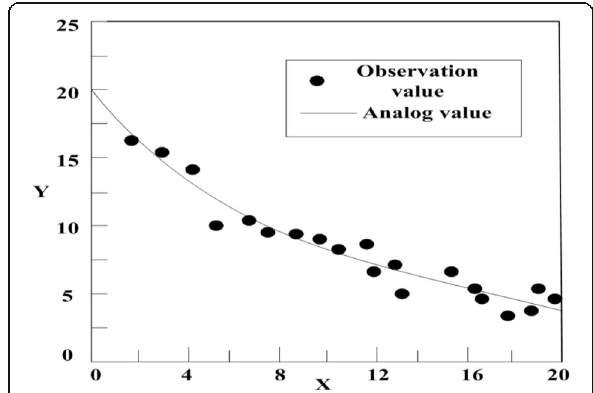
Fig. 4 Fitting curve of parameter identification